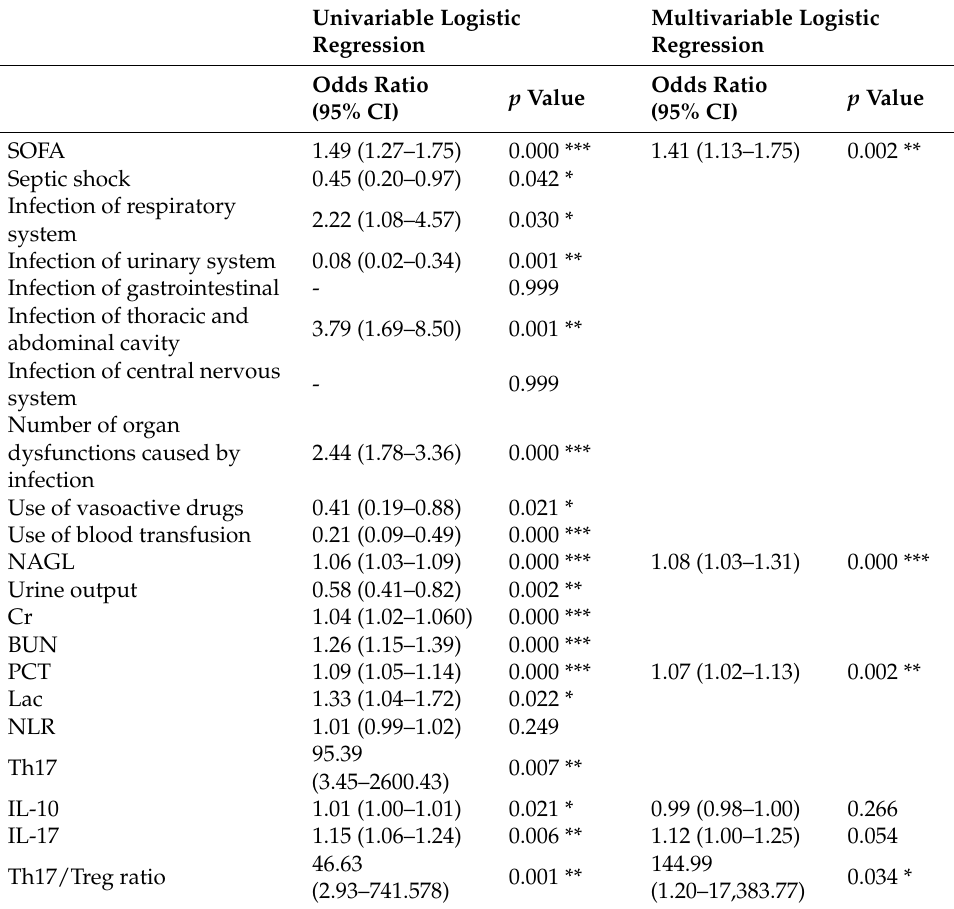
Table 2. Risk factor analysis for the occurrence of